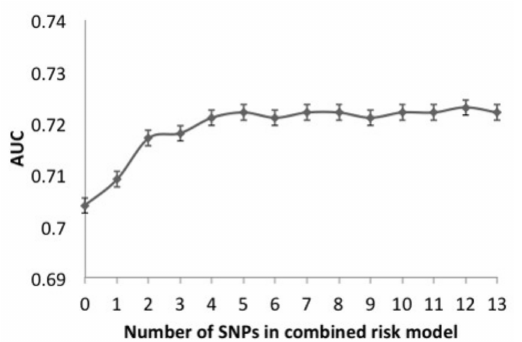
Figure 6. Area under the ROC of nongenetic and genetic combined risk model based on increasing number of SNPs. SNPs were added in order of the odds ratio (see Table 2); starting with FTO based on 1 SNP and ending with SLC22A1 (13 SNPs). Nongenetic risk model (0 SNP) was based on SBP, DM duration, waist circumference, HbA1c, albuminuria categories, total cholesterol, high-density lipoprotein, low-density lipoprotein, triglycerides. ROC, receiver operating characteristic curve; AUC, area under ROC